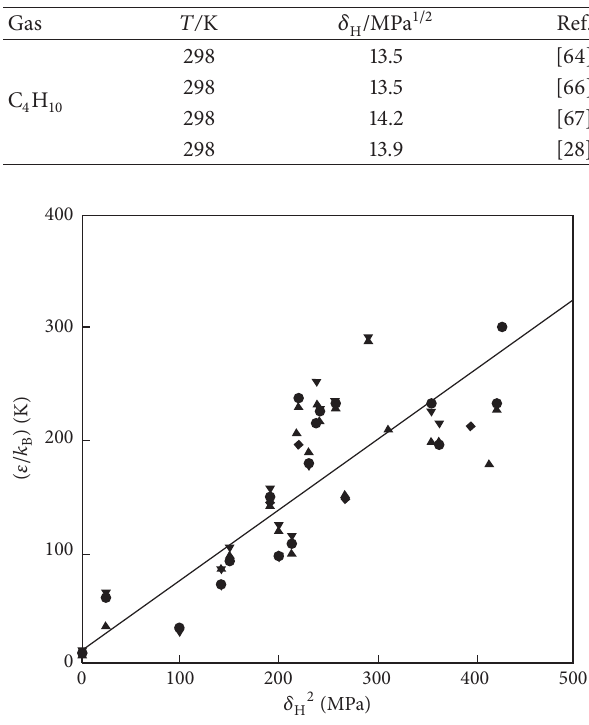
Figure 1: The depth of the collision potential well of gas molecules, ( 𝜀/𝑘 B )/K, plotted against their cohesive denisty energy at the boiling point, 𝛿 H 2 /MPa. The symbols are for ( 𝜀/𝑘 B )/K from [12] e , from [13] 󳶃 , from [14] 󳵳 , and from [15] ⧫